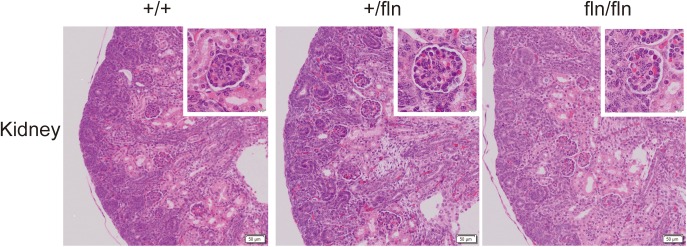
No kidney defects were detected in homozygous. Representative sections of H&E staining on kidney samples from +/+ (n = 3), +/fln (n = 3), and fln/fln (n = 3) embryos at E18.5. Bar = 50 μm at low magnification, Bar = 10 μm at higher magnification.